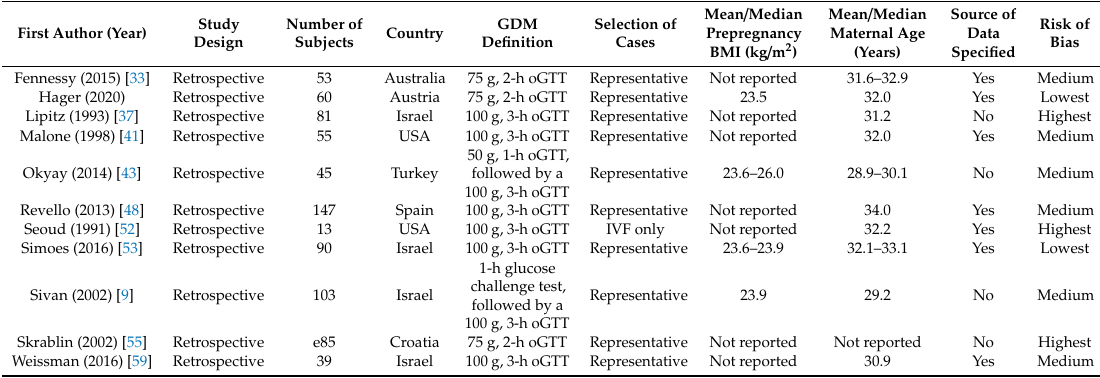
Figure 4. Funnel plots for ( A ) the meta-analysis of all eligible studies and ( B ) the meta-analysis of all studies with a sound GDM definition. Table 3. Meta-analysis of studies with a sound GDM definition: overview on study design and GDM definitions used.